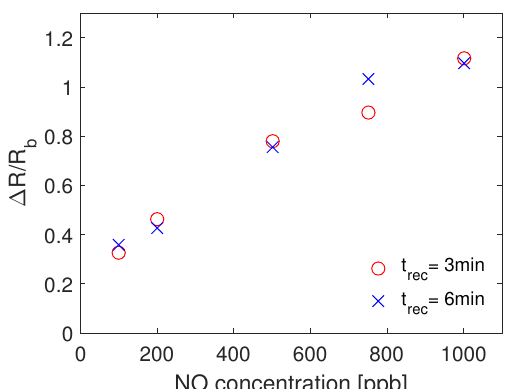
Figure 8. The mean of the response of the sensor for different concentration of NO when t ret = 3 min and t ret = 6 min. The injection time in both cases is t inj = 30